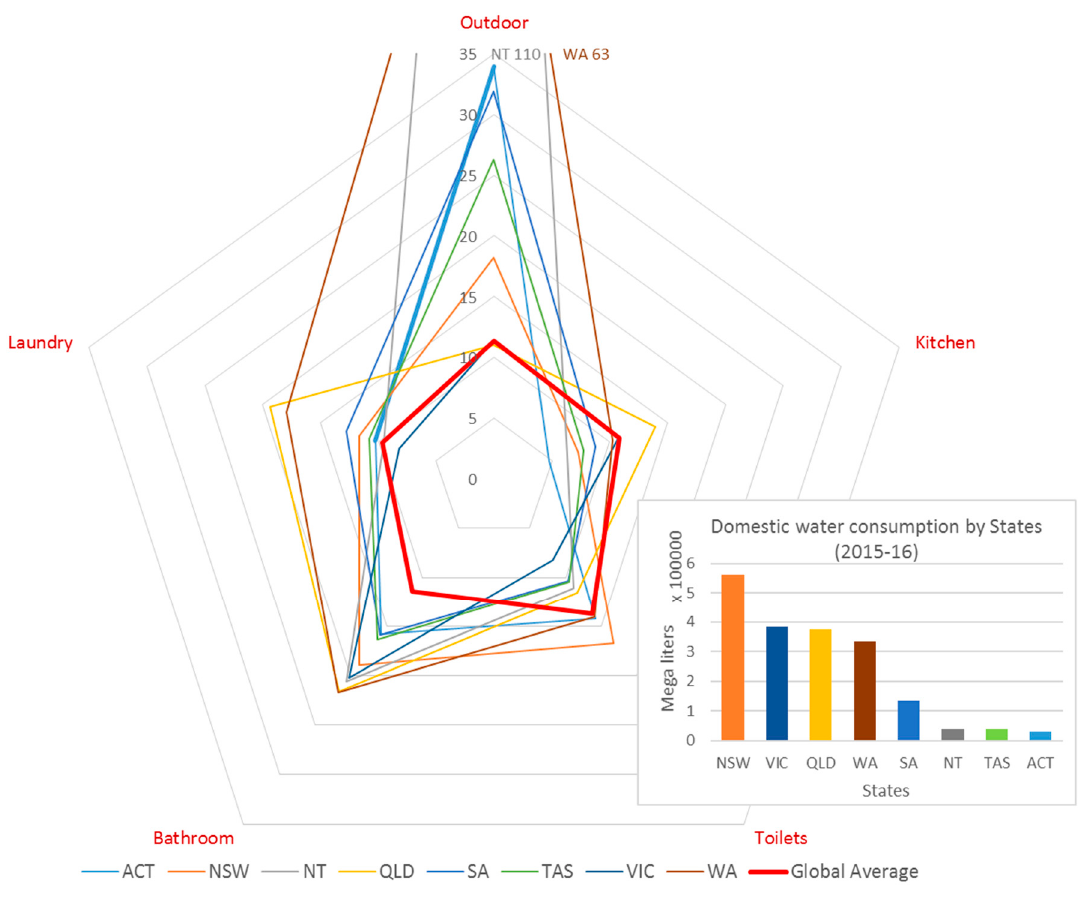
Figure 3. Domestic water consumption by each state; total consumption on right (in frame graph) and consumption patterns in each state on right side (2015–2016) (Data sources: [31,32,34–38]).